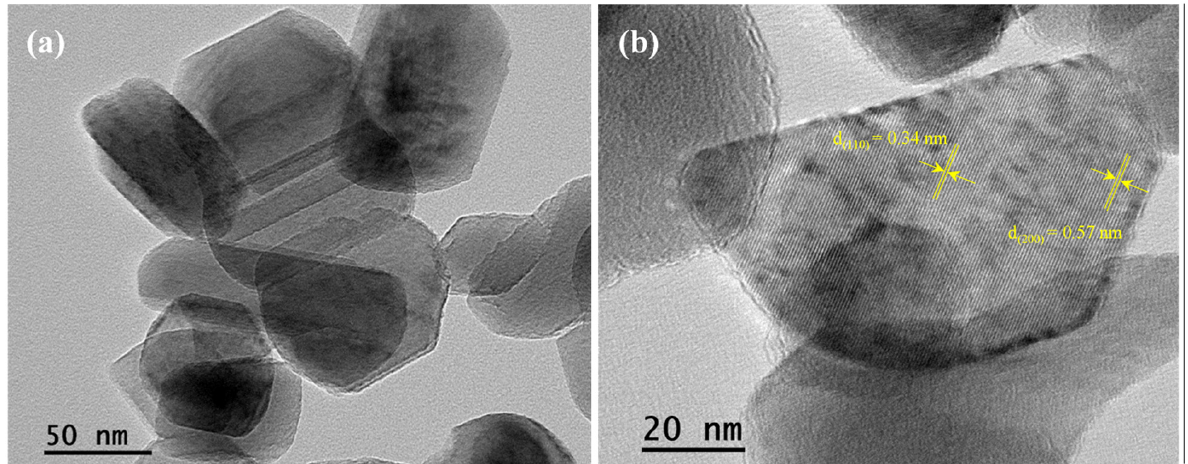
Figure 3. ( a ) FE-TEM image and ( b ) HR-TEM image of the calcined oval-shaped V 2 O 5 nanoparticles sample.